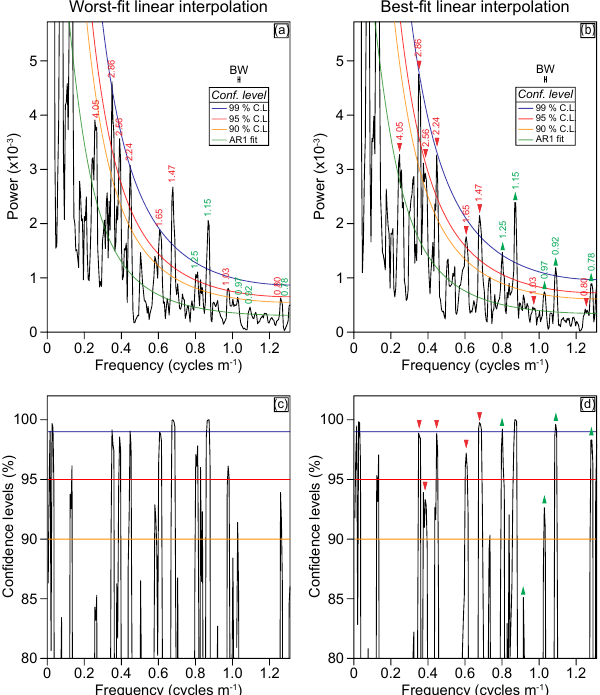
Figure A2. Comparison of spectra of the resampled time series for the worst-fit case ( a and c ) and for the best-fit case ( b and d ). Spec- tra (a) and (b) are calculated using the 2 π multi-taper method with confidence levels calculated using the method of Mann and Lees (1996) with a Tukey’s end-point rule (Meyers, 2014). Panels (c) and (d) show the confidence levels compared to a red noise. Red ar- rows indicate the frequency at which powers and confidence levels decrease from the worst-fit case to the best-fit case. Green arrows display the opposite